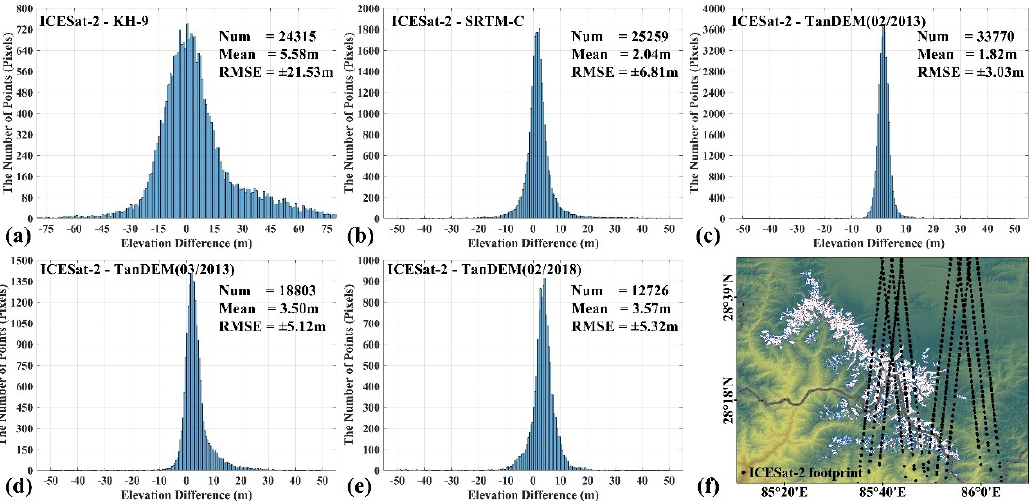
Figure 4. Results of evaluating the KH-9, SRTM-C and TanDEM-X DEMs with the ICESat-2/ATLAS ATL06 elevation product ( a – e ). Subfigure ( f ) shows the footprints of utilized ICESat-2 points.